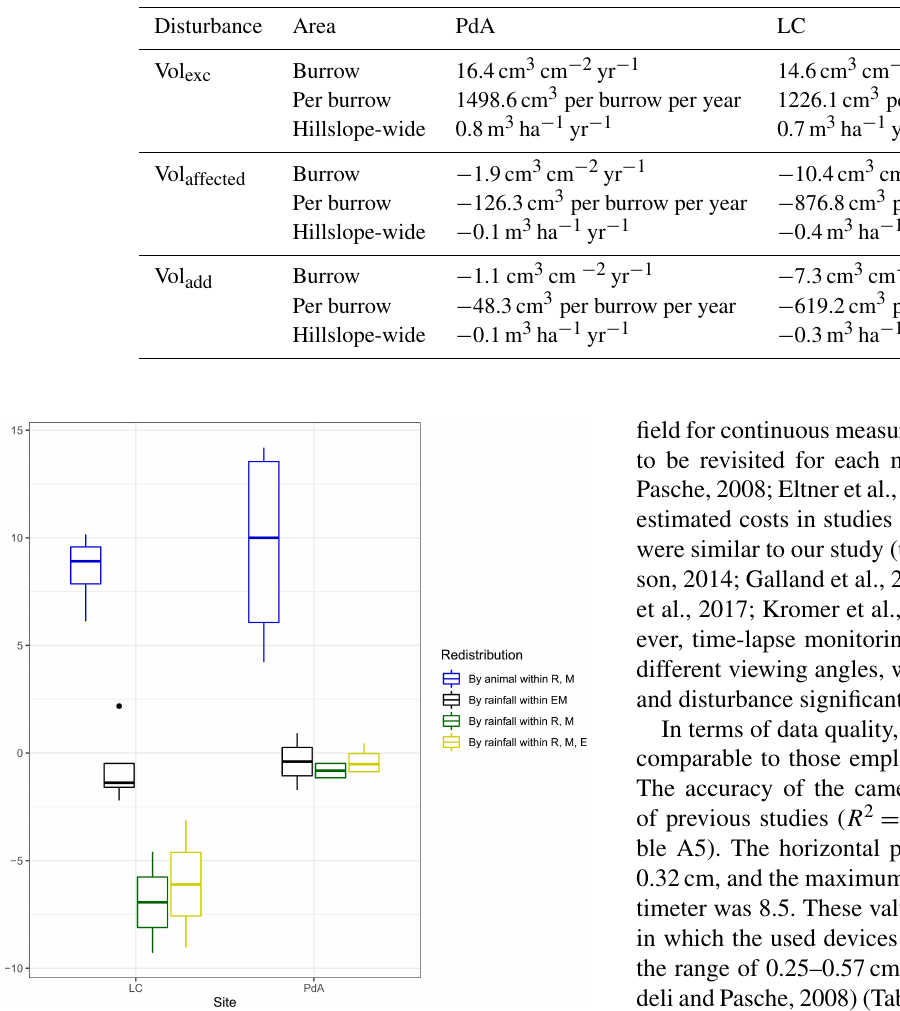
Figure 7. Cumulative volume of the redistributed sediment for the time period of 7 months for all cameras. Positive values indicate sediment accumulation. Negative values indicate sediment erosion. Whiskers indicate the median of sediment redistribution. E is the burrow entrance, M is the mound, R is the burrow roof, EM is the burrow-embedded area, LC stands for National Park La Campana (in the Mediterranean climate zone), and PdA stands for National Park Pan de Azúcar (in the arid climate